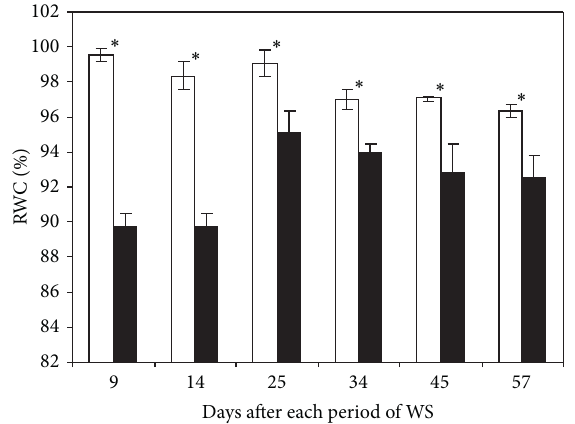
Figure 2: Leaf relative water content (%) in fully expanded leaves of banana plants. Treatments were regularly irrigated ( ◻ ) and water- stressed ( ◼ ) banana plants. Data are means ± SE and each value was determined in three different plants with three replicates per treatment (𝑛 = 9) . Data were compared for each date using the least significant difference (LSD) test. Significant differences at 𝑃 ≤ 0.05 are represented by an asterisk ( ∗ ). WS: water